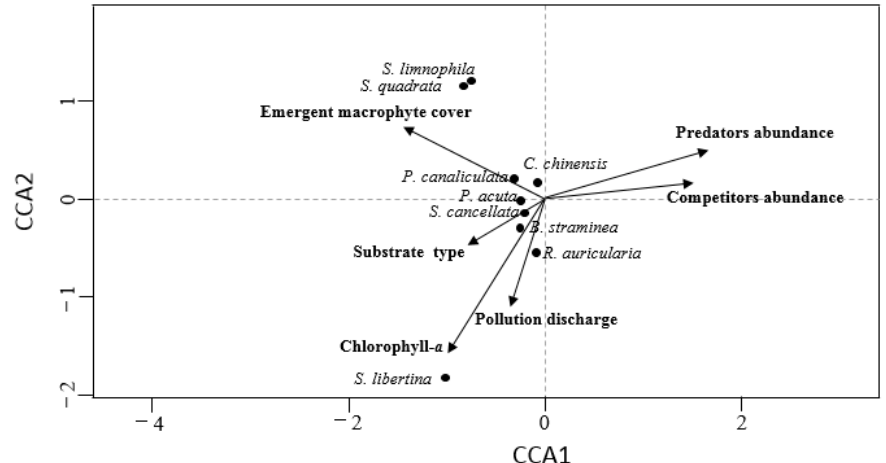
Figure 7. Canonical correspondence analysis ordination plot of snail species and predictor varia- bles.